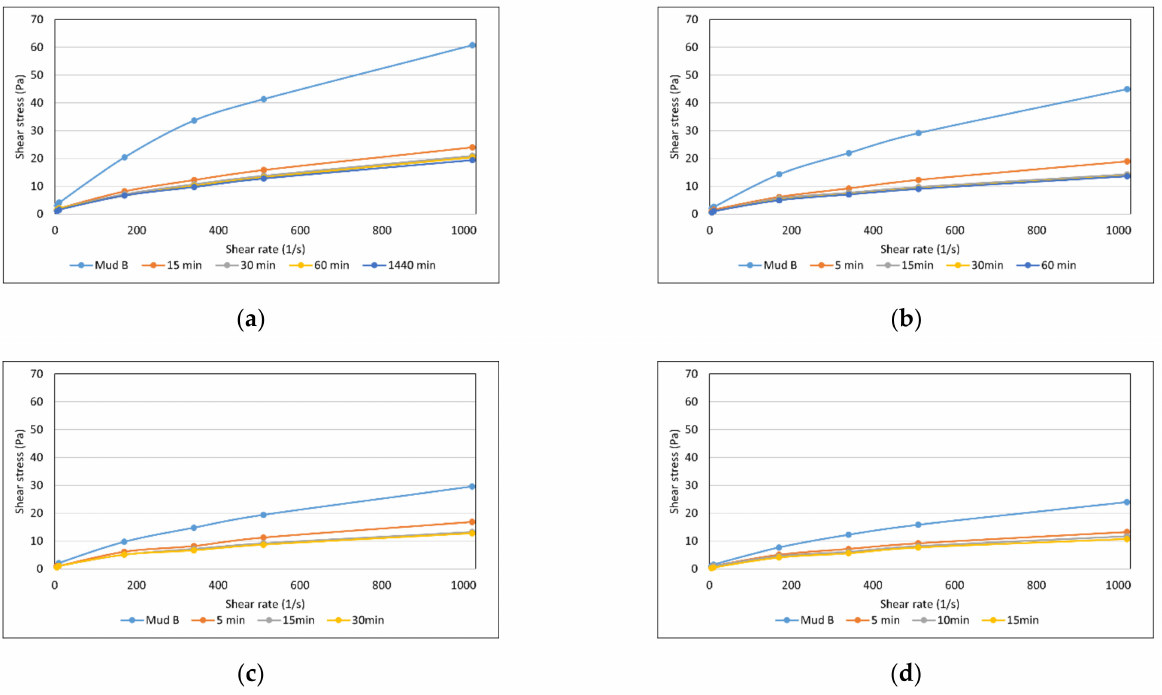
Figure 6. Flow curves of drilling mud B with the addition of 1.0% urea peroxide: ( a ) at 20 ◦ C, ( b ) at 40 ◦ C, ( c ) at 60 ◦ C, ( d ) at 80 ◦